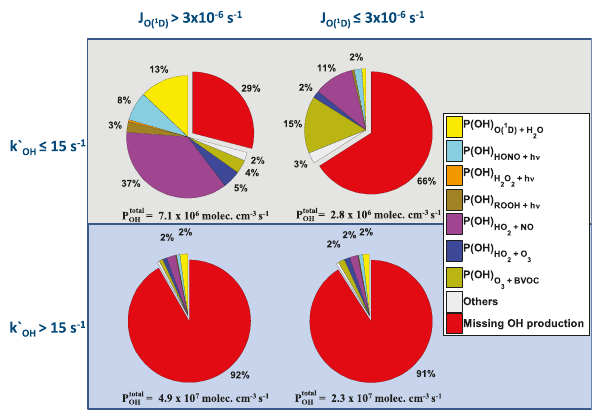
Figure 15. Simulated contributions to the OH production during HUMPPA-COPEC-2010. Partitioning at different conditions of ra- diation and observed total OH reactivity with respect to the total OH production derived from measured OH concentrations and the total OH reactivity.